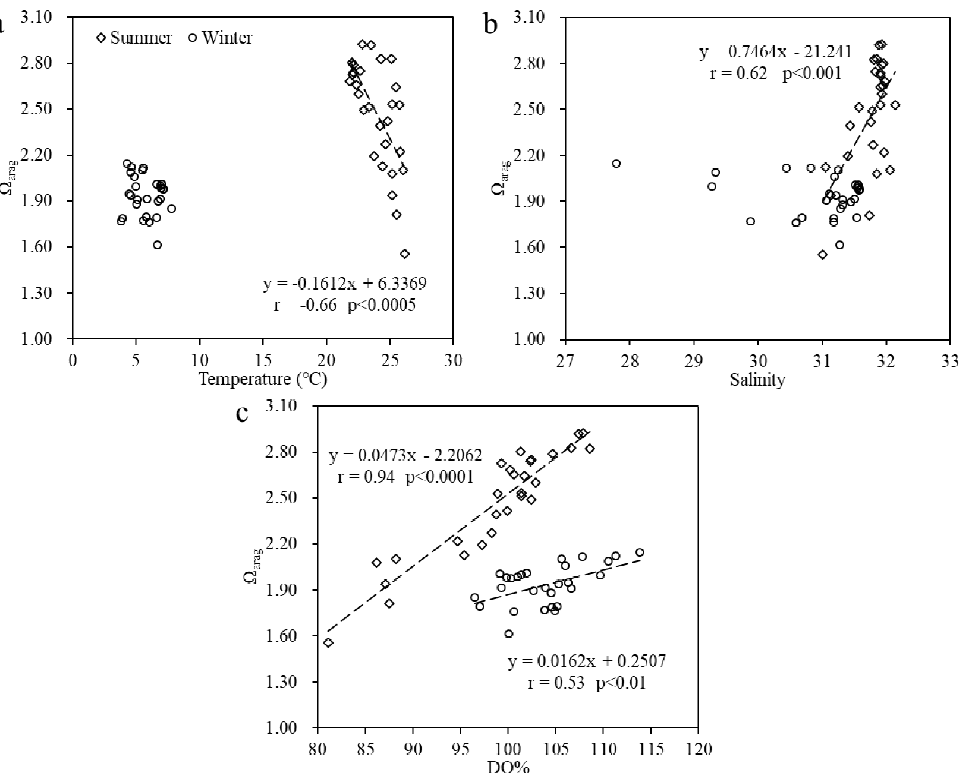
Figure 4. Scatterplots of seawater surface Ω arag vs. temperature ( a ), salinity ( b ) and DO% ( c ) in JZB during summer (28 June 2017) and winter (17 January 2017). Diamonds and circles represent the summer cruise and winter cruise, respectively.